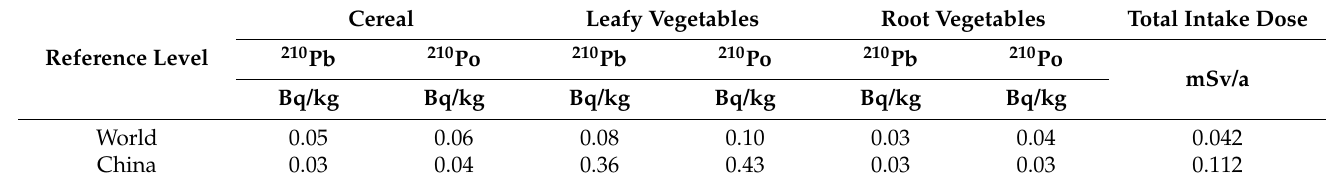
Table 8. The annual ingestion doses contributed by 210 Pb and 210 Po in foods (mSv/a).